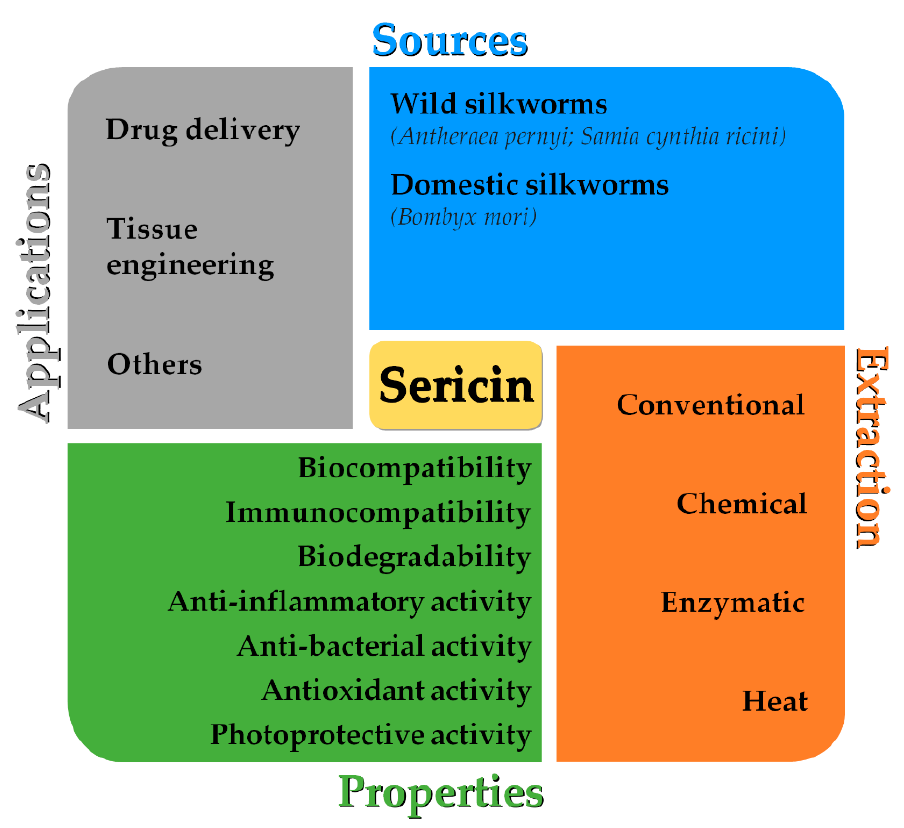
Figure 1. Schematic diagram of sericin sources, extraction methods, properties, and biomedical and pharmaceutical applications.